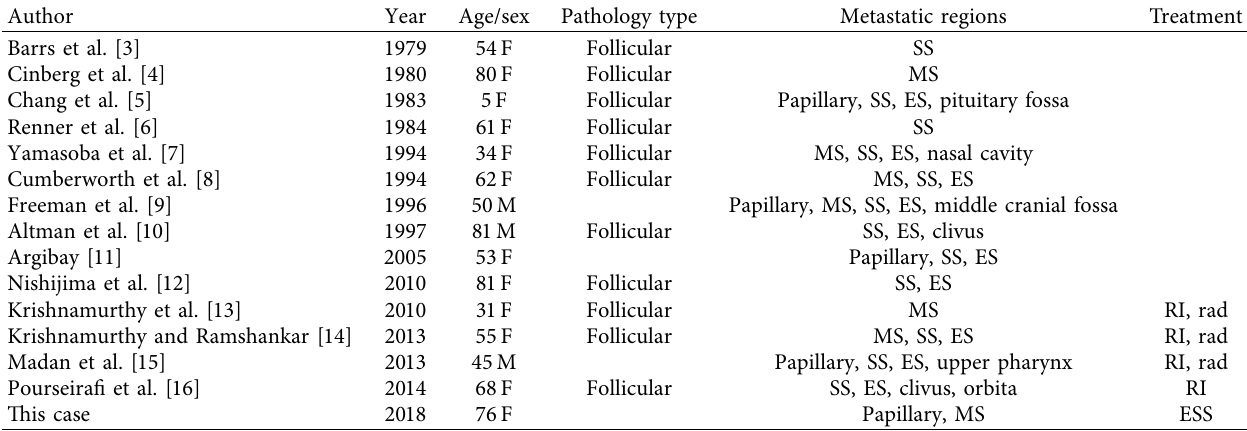
Table 1: Metastasis of the thyroid carcinomas to the paranasal